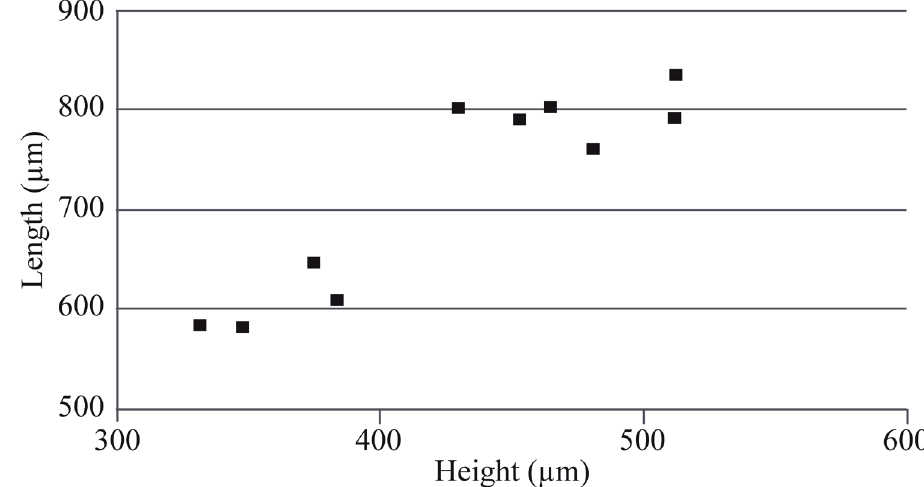
Fig. 5. Height/length diagram of Bairdia ? huberti sp.